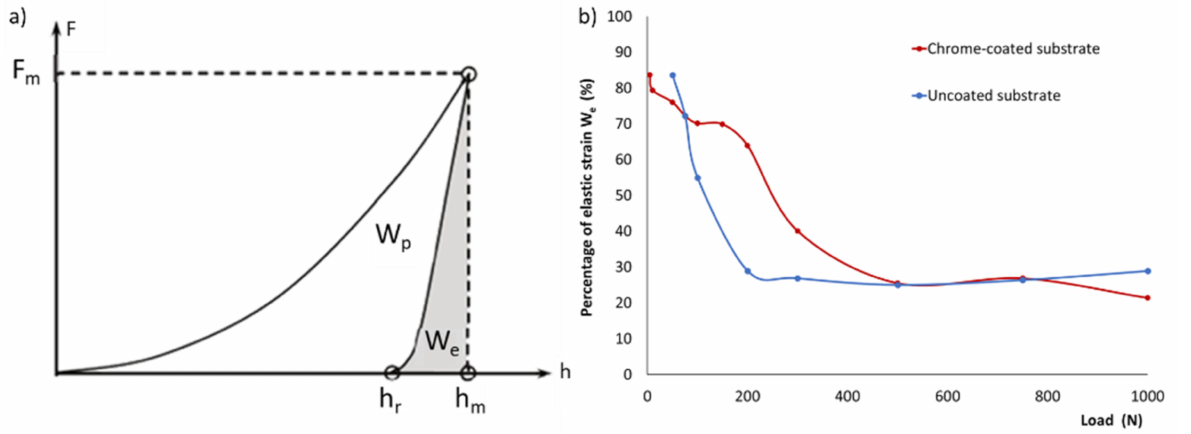
Figure 4. ( a ) Determination of elastic and plastic deformation work from a loading–unloading curve. ( b ) Evolution of the percentage of elastic strain energy expended during Brinell indentation tests as a function of the applied load (with a 5 mm ball and a deposit thickness of 40 µ